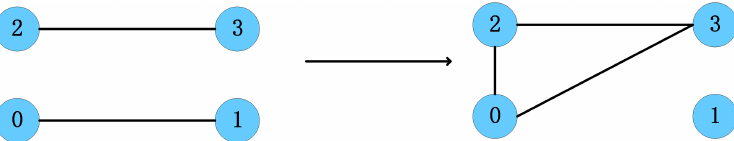
Figure 1. Process of generating GHZ state with 2 pairs of Bell states through quantum walk.